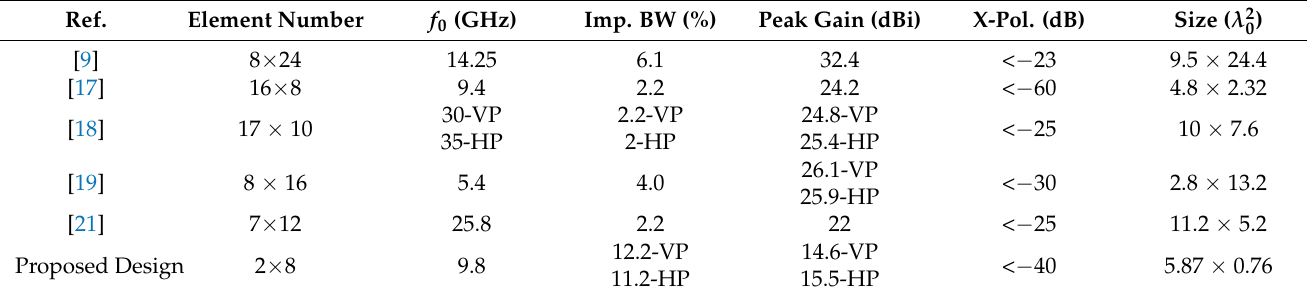
Table 1. Comparison of various dual-polarized slotted waveguide array antennas.